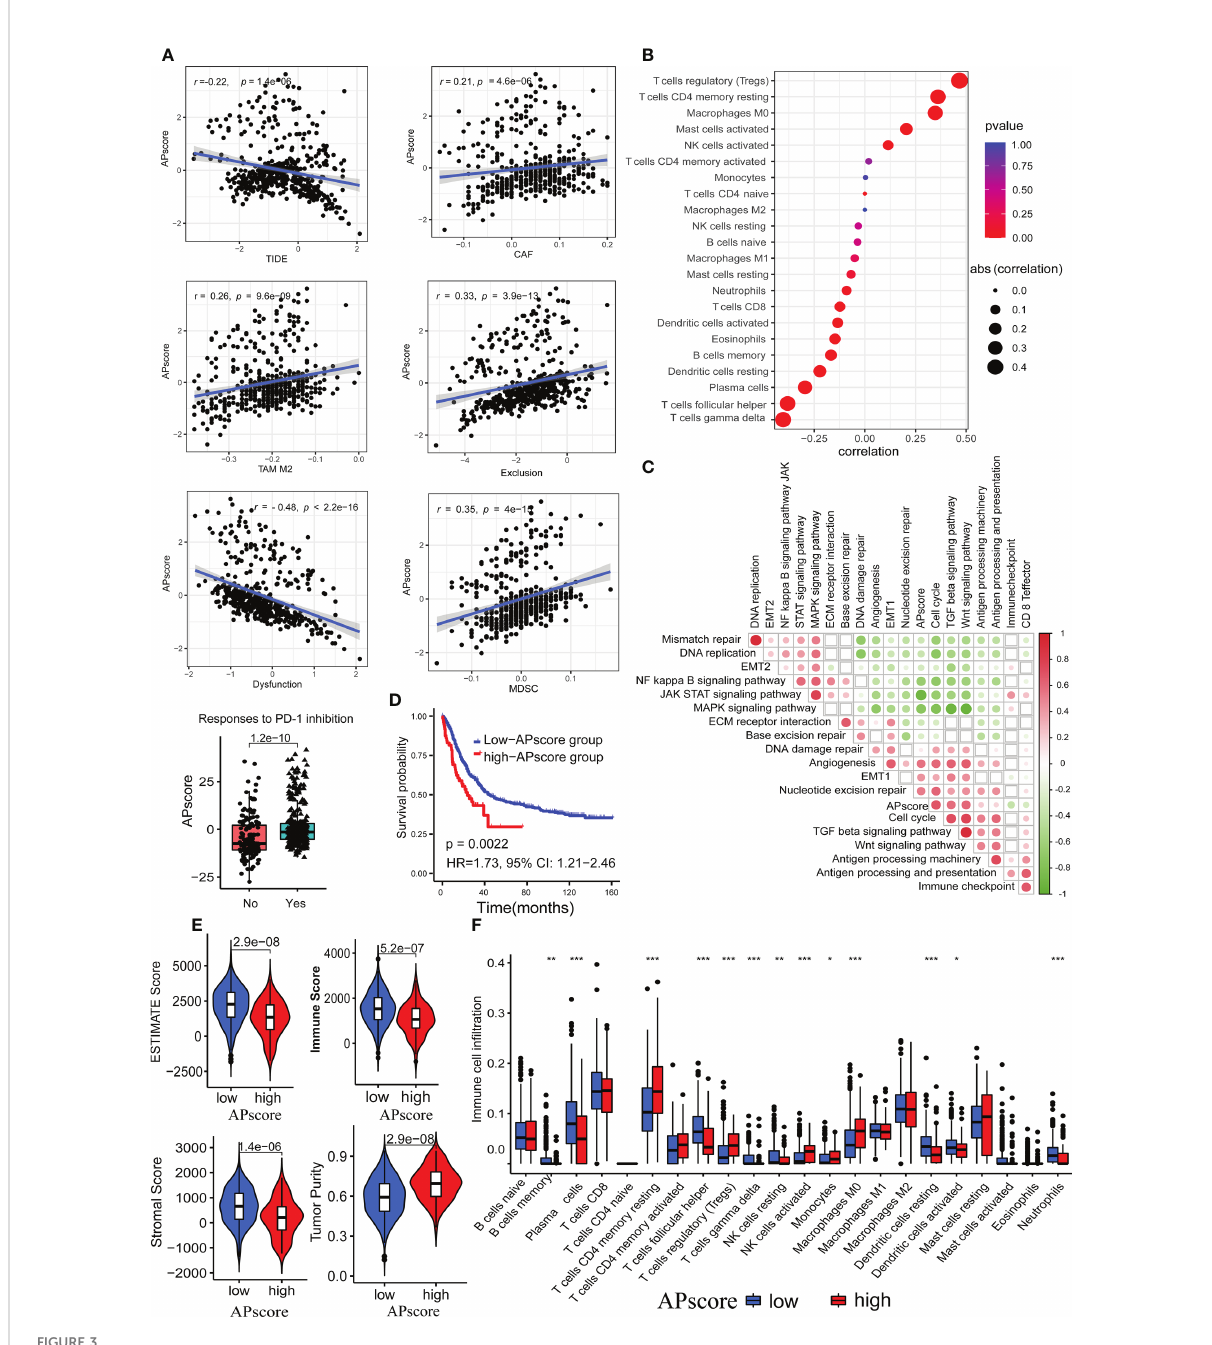
FIGURE 3 The associations of the APscore with immunotherapy response, immune microenvironment, and survival in aGC patients. (A) The relationship of the APscore with indicators of immunotherapy response predicted by the TIDE algorithm. (B) The relationship of the APscore with in fi ltration of the 22 immune cells calculated by the CIBERSORT algorithm. (C) The interrelations of the APscore with PCA genes scores of important biological pathways of GC. The white squares represent no statistically signi fi cant. (D) Kaplan-Meier survival plots in both groups of 467 aGC patients. (E) Comparison of the tumor purity, estimate, immune, and stromal scores between the high-APscore and low APscore-groups. (F) Comparison of the 22 immune cells proportions between the high-APscore and low APscore-groups. Asterisks denote signi fi cant differences (*p< 0.05; **p< 0.01; ***p<